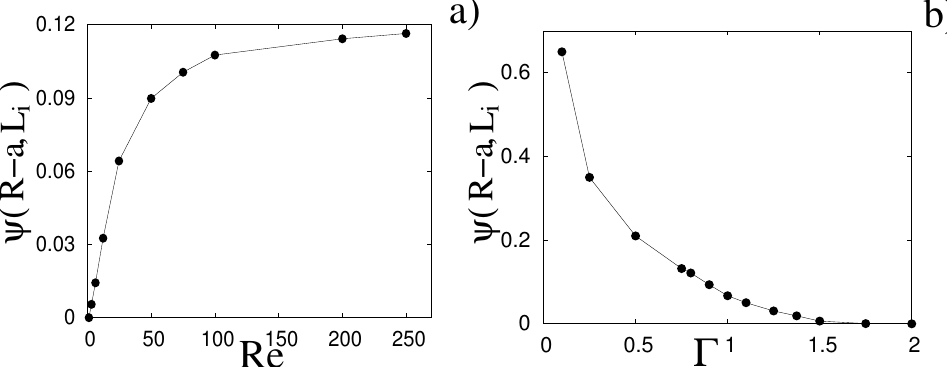
Figure 8. ( a ) Stokes streamfunction ψ ( R − a , L i ) as function of Re for the case at Γ = 1; ( b ) ψ ( R − a , L i ) as function of Γ at Re =